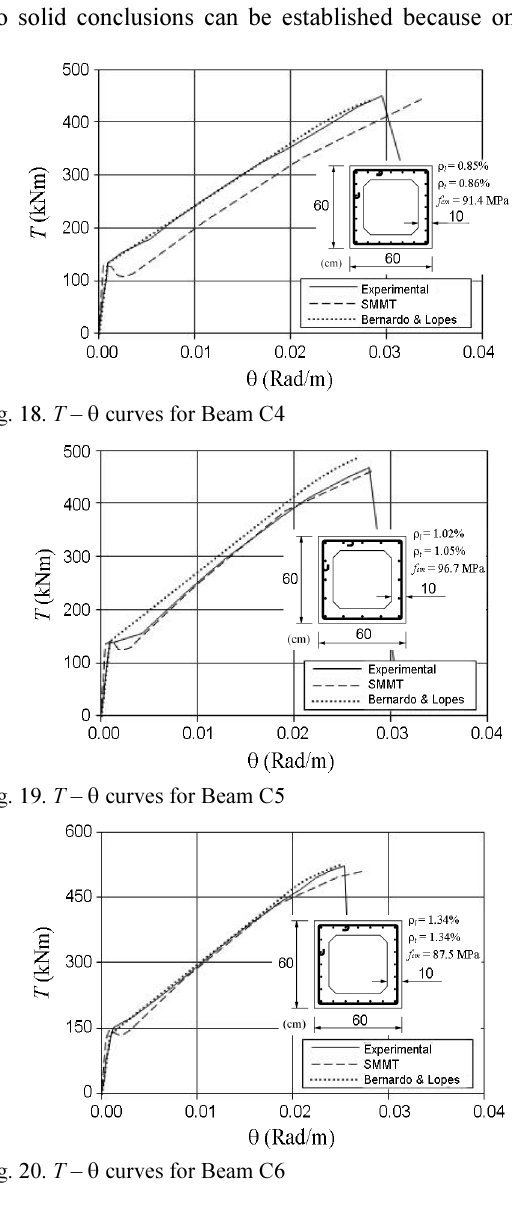
Fig. 20. T – θ curves for Beam C6